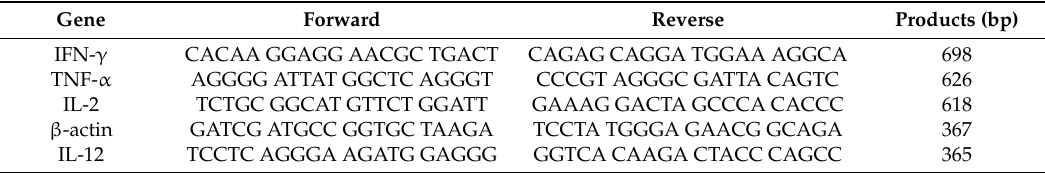
Table 3. Primers sequence of polymerase chain reaction